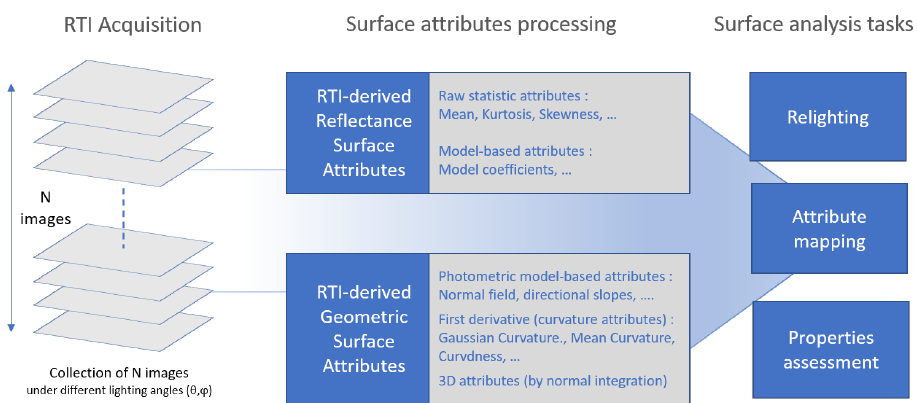
Figure 2. Description of an RTI acquisition and the different types of